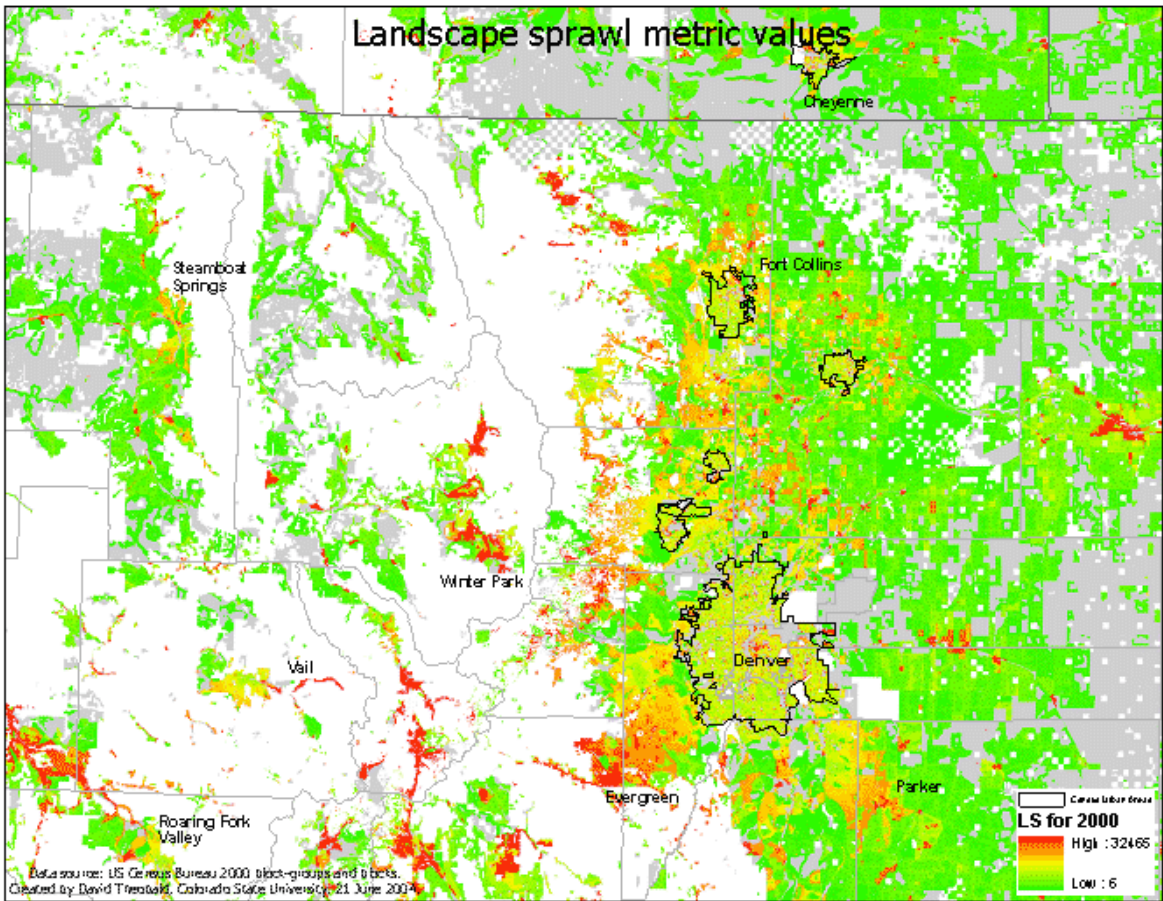
Fig. 16. A detailed map of the Landscape Sprawl (LS) metric values for northern Colorado, USA in 2000. Higher values (red) indicate more sprawl or greater effect on the landscape. Private rural lands with no housing density are shown by gray, and public/protected lands are shown in white. Note that the LS metric is evaluated for all areas, and exurban/rural sprawl can be seen to extend beyond the boundaries of the 2000 Census Urban Areas (black